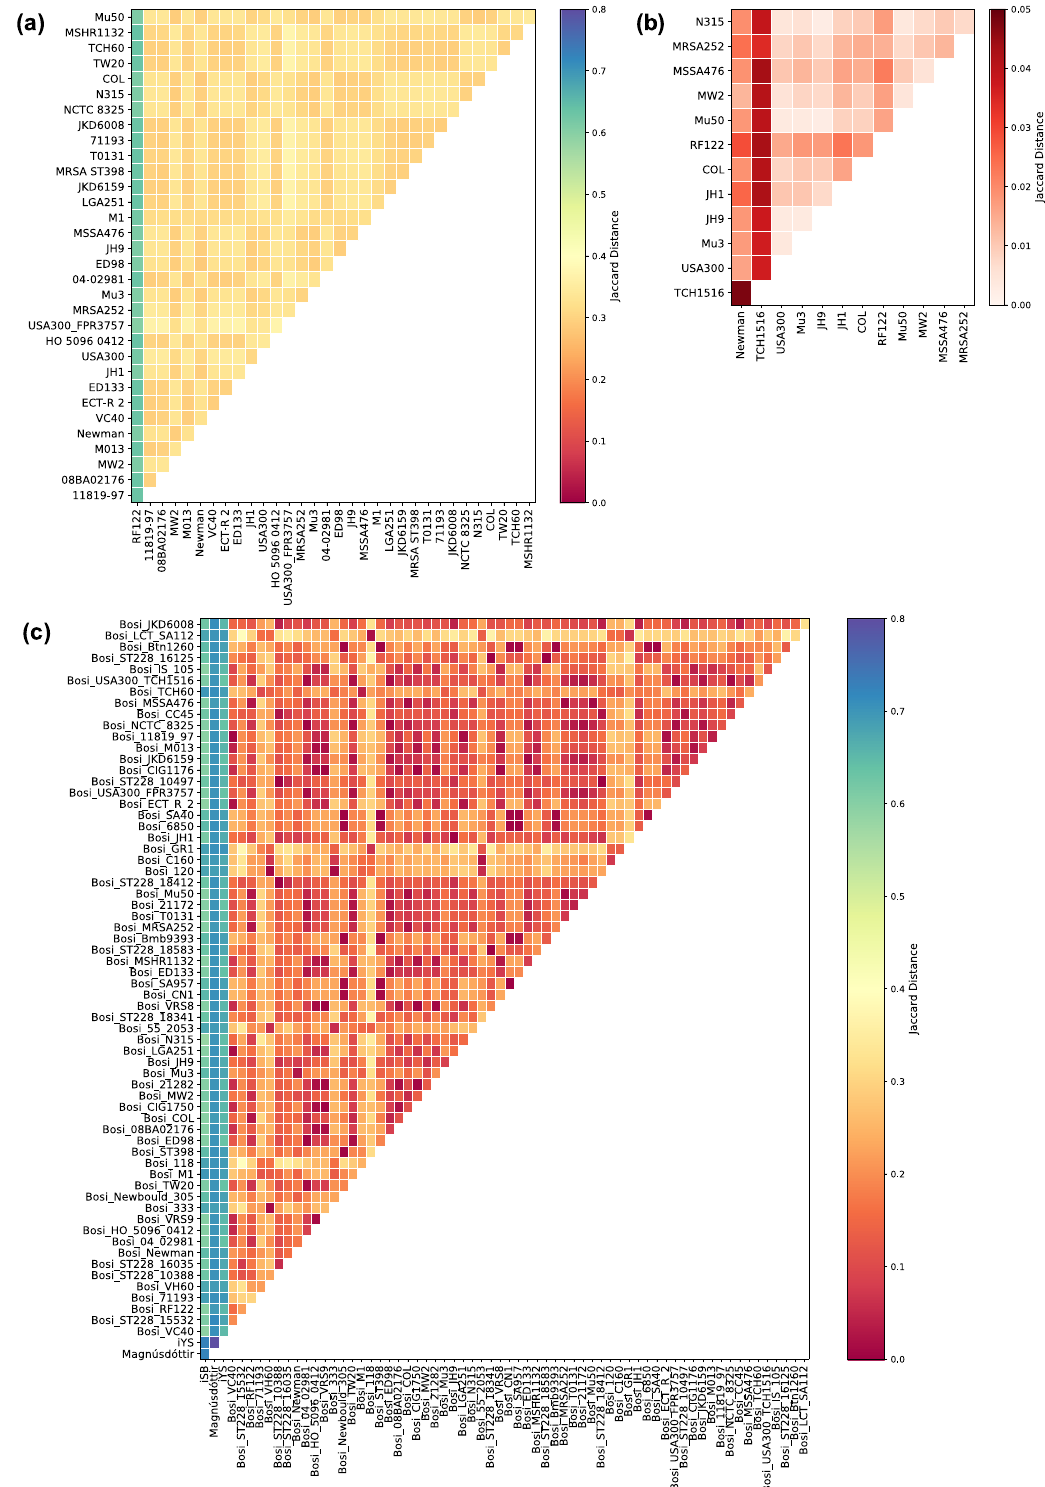
Fig. 5 Model comparison based on Jaccard distance between reaction sets. The models were divided into three groups based on their metabolite and reaction identi fi ers: ( a ) has all models of the Path2Models project with consistently mixed identi fi ers, ( b ) has all models with KEGG identi fi ers (hence, all GEMs by Lee et al.), and ( c ) contains all models with BiGG identi fi ers. Within the three groups, all pairwise Jaccard distances were calculated based on the models ’ reaction sets. The distances are displayed in the heat map. The color bar range is equal for ( a ) and ( c ) for better comparison. As the distances in ( b ) are much smaller, the color bar ’ s range was